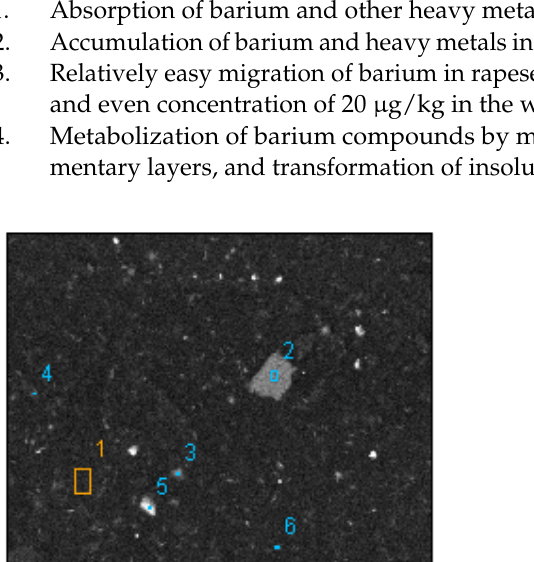
Figure 8. Selected forms of paint coating degradation in areas of bacterial colony development after 8 weeks of exposition. SEM, clusters of microfractures ( a , b ); cavities ( c – e ) and clusters of elongated shapes ( f ).